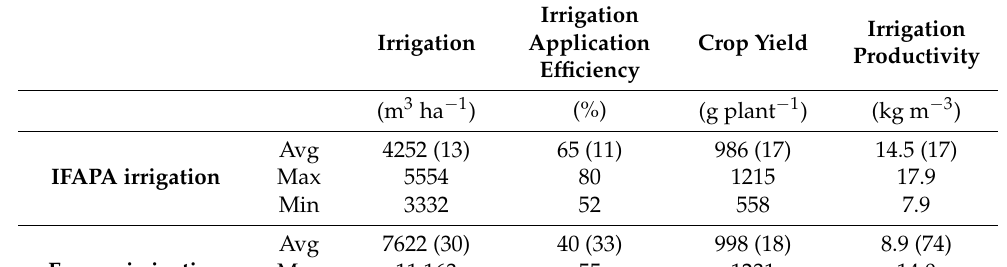
Irrigation Application Crop Yield Efficiency